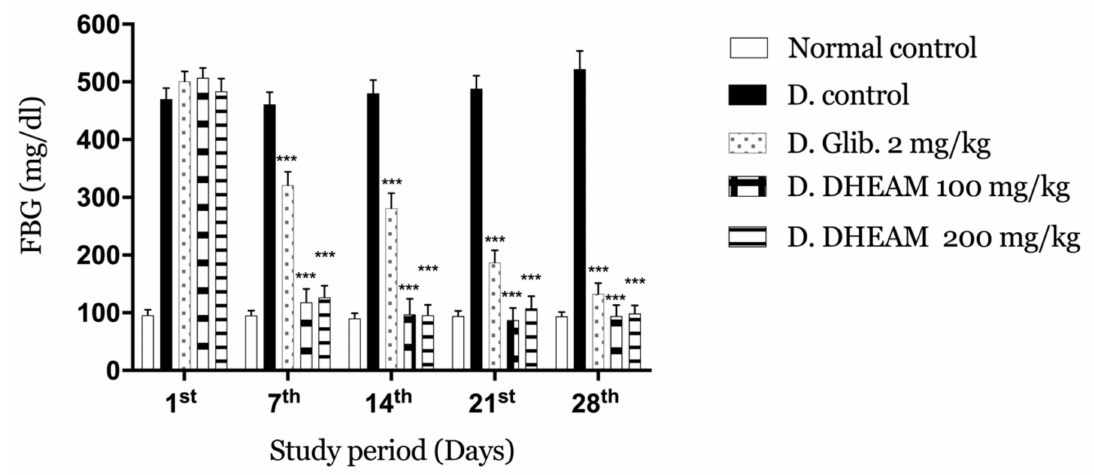
Figure 2. The e ff ect of DHEAM on mice FBG (Fasting blood glucose) during the four weeks of the study. Values are expressed as mean ± SD (n = 5 mice). *** p < 0.001 compared to diabetic